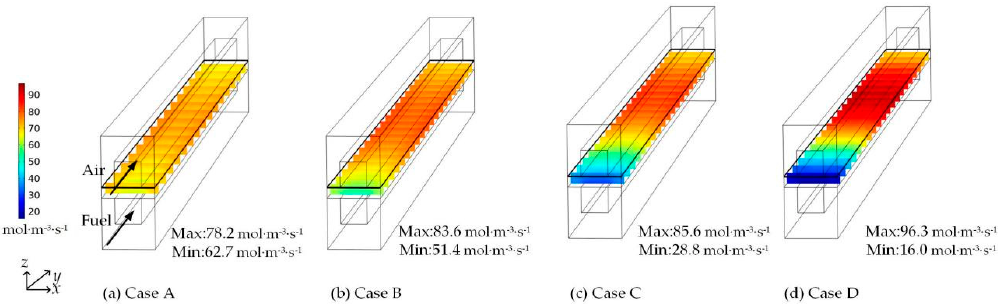
Figure 4. Distribution of MSR reaction rate under different methane Pre-Reforming percentages.